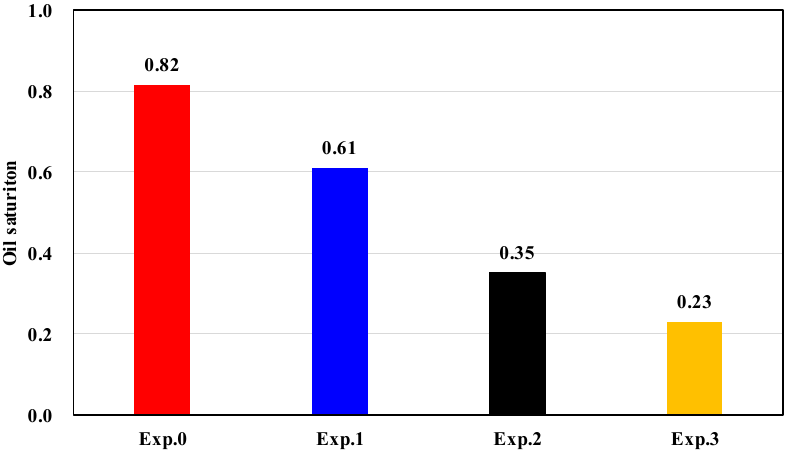
Figure 7. Oil saturation distribution of different stages.